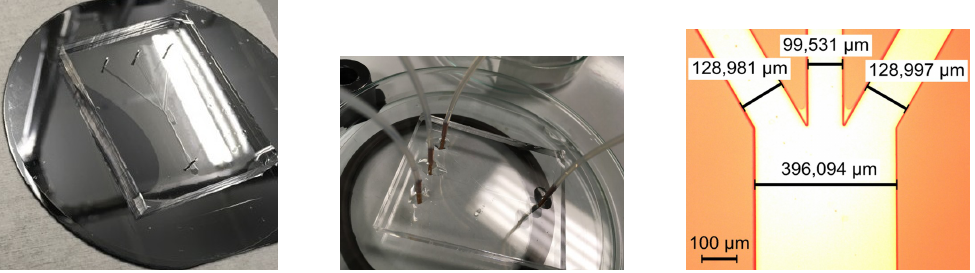
Figure 13. Microfabrication process: PDMS microchannel on silicon mold and final aspect of the microfluidic device and microscope detail on the region of